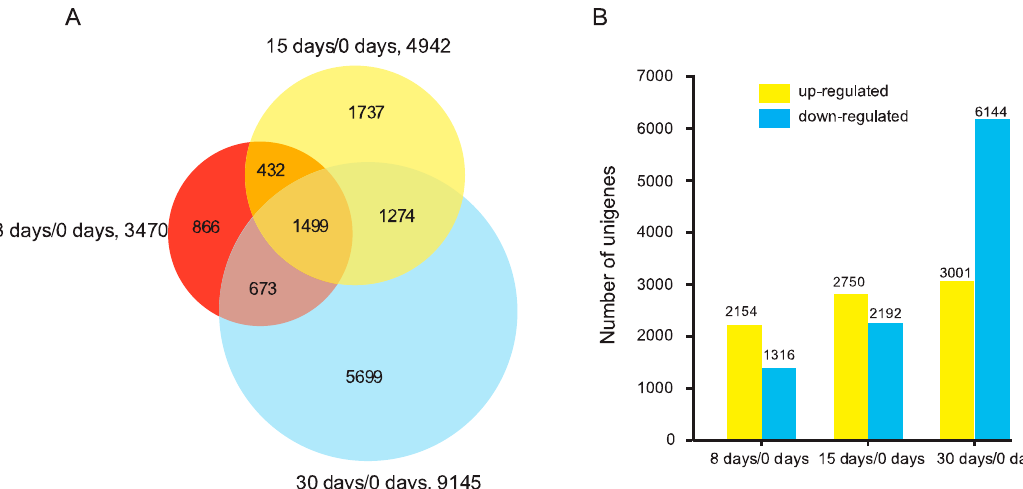
Figure 1. The differentially expressed genes (DEGs) in different comparisons (8 days/0 days, 15 days/0 days, and 30 days/0 days) during graft union development in pecan homografts.